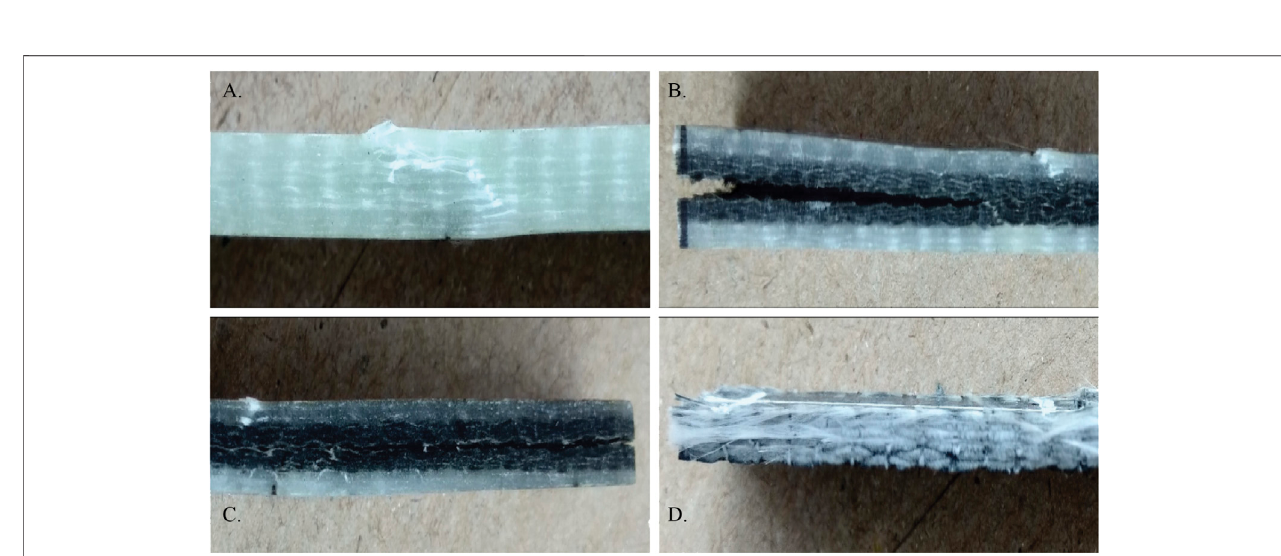
FIGURE 4 | Lateral view of failed fl exural specimens. (A) EGC, (B) HGB, (C) MHC, (D) MEG.